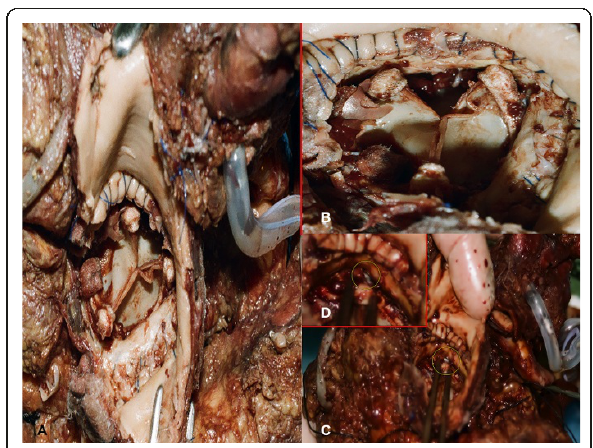
Figure 1 Macroscopic findings . (A) At the post-mortem inspection, a horizontal aortotomy was evident with prosthetic valve in situ after aorta was opened. (B) The coronary ostia are not visible. (C) A metal probe inserted into right coronary artery distally cut (insert in D), demonstrated the entrapment of the ostium in a stitch at the level of prosthetic annulus.